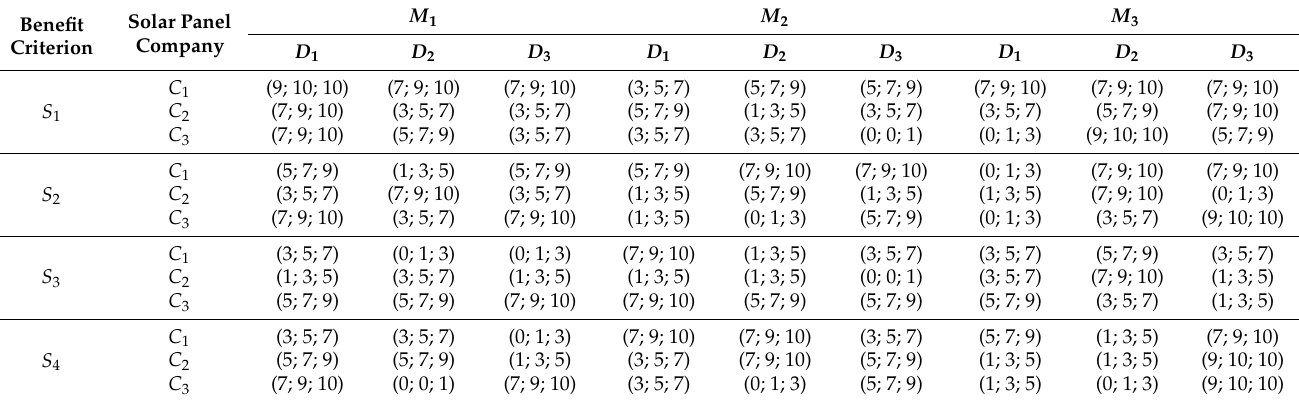
Table 8. Triangular fuzzy numbers of the evaluations for each manufacturing company.